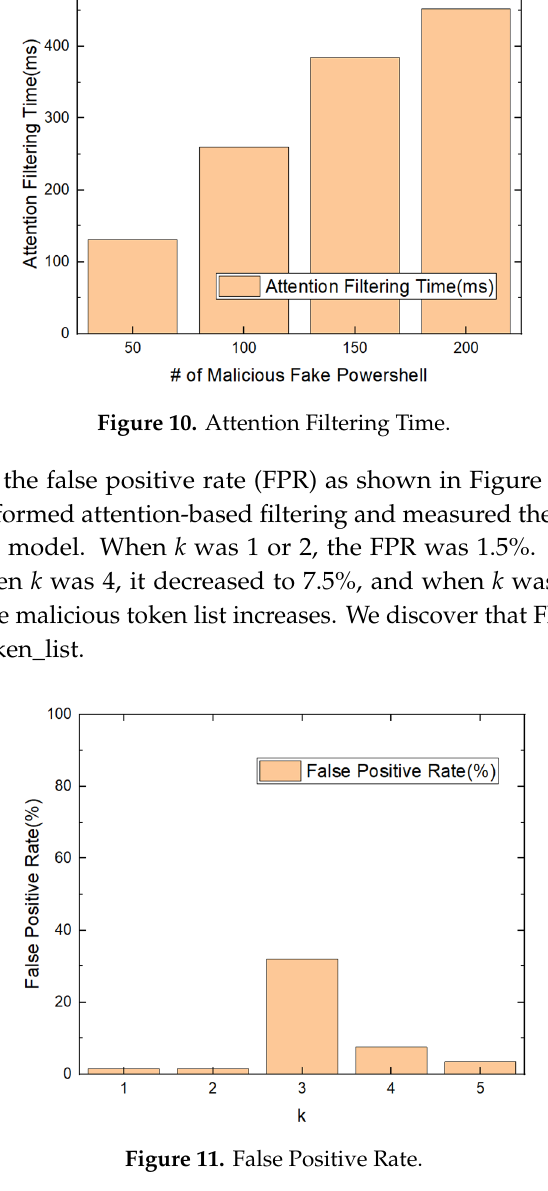
Figure 10. Attention Filtering Time.